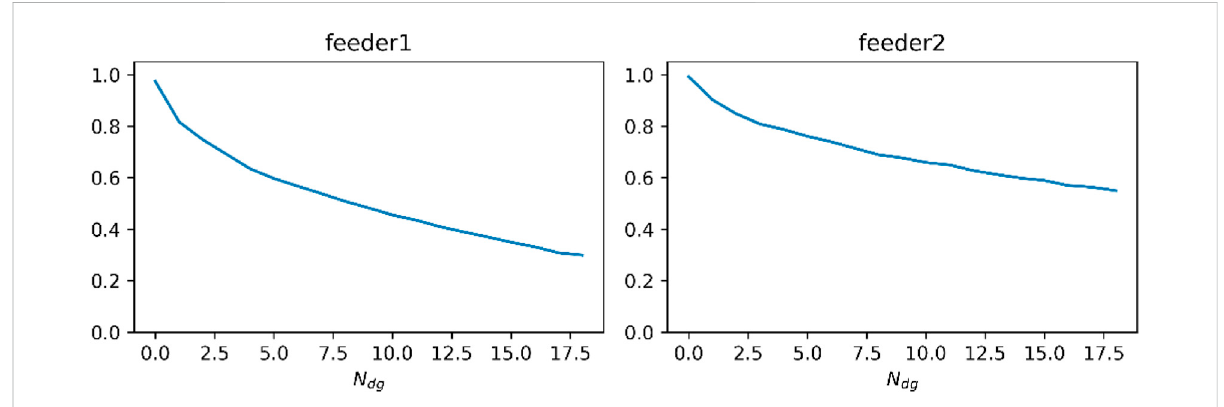
FIGURE 7 Percentage of data requirement